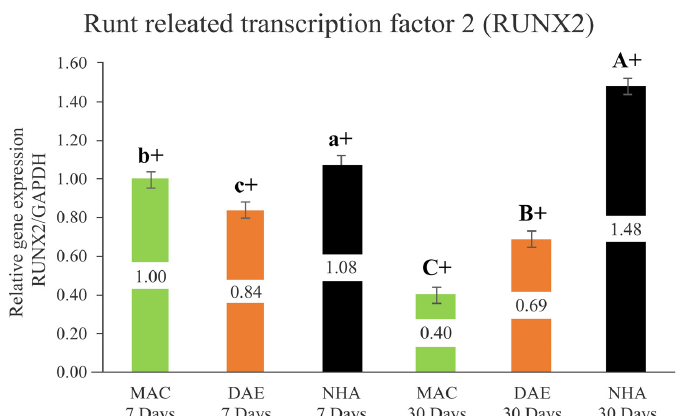
Figure 4. Relative expression of Runx2/GAPDH (Runx2/GAPDH) in all groups (mean values, error bars show 95% confidence interval). Lower case letters represent the analysis of 7 days, and capital letters the analysis of 30 days. Different letters indicate a statistically significant difference between groups. The + sign indicates a statistically significant difference (MAC: p < 0.001; DAE: p < 0.001; NHA: p < 0.001) for intragroup analyses, considering the same surface treatment and different assessment times.